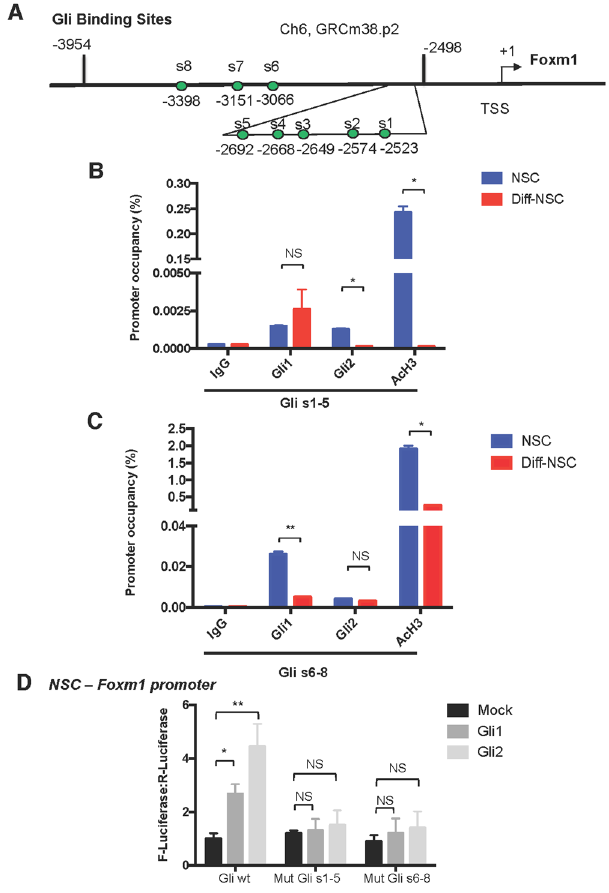
Figure 3. Foxm1 promoter occupancy by Gli1 and Gli2. ( A ) Schematic of the Foxm1 promoter showing locations of the 8 putative Gli-responsive elements (s1–s8). ( B , C) qPCR-ChIP assay of endogenous Gli1 and Gli2 occupancy of the Foxm1 promoter region in NSCs and Diff-NSCs. Immunoprecipitation with IgG was performed as control. Anti-acetyl-H3 antibodies was used to detect Foxm1 transcriptional activation. Eluted DNA was qPCR-amplified using primers encompassing putative Gli binding sites [s1–s5 ( B ) and s6–s8 (C) ]. Results are expressed as fold induction values relative to ChIP input controls. B-actin was utilized as unrelated chromatin control and is presented in Supplementary Figure 5 A. Bars represent means (SD) of three independent experiments. P values vs. Diff-NSCs (Mann-Whitney U test): ( B ) * P < 0.05: 0.04797 (s1- 5, Gli2), 0.03271 (s1-5, AcH3); NS (not significant): 0.2514 (s1-5, Gli1). ( C ) * P < 0.05: 0.0490 (s6-8, AcH3); ** P < 0.01: 0.001374 (s6-8, Gli1); NS: 0.296763205 (s6-8, Gli2). ( D ) Luciferase activity induced in the Foxm1 promoter region in NSCs by Gli1, Gli2, and Mock (negative control, PCDNA). Results are normalized to pRL- CMV-Renilla luciferase (R-Luciferase). Bars represent means (SD) of at least three independent experiments, each performed in triplicate. P values vs. control cells (One-way ANOVA test): * P < 0.05: 0.02 (Gli wt-Gli1); ** P < 0.01: 0.005 (Gli wt-Gli2), NS: Not significant 0.072 (Mut Gli s1-5-Gli1); 0.066(Mut Gli s1-5-Gli2); 0.083 (Mut Gli s6-8-Gli1); 0.077(Mut Gli